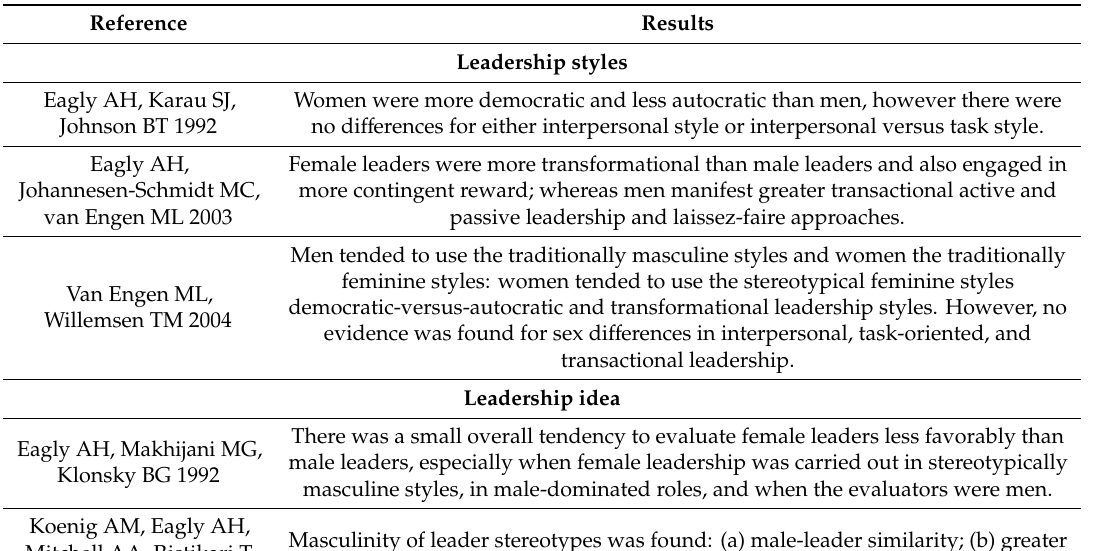
Table 3. Summary of meta-analyses regarding di ff erences between women and